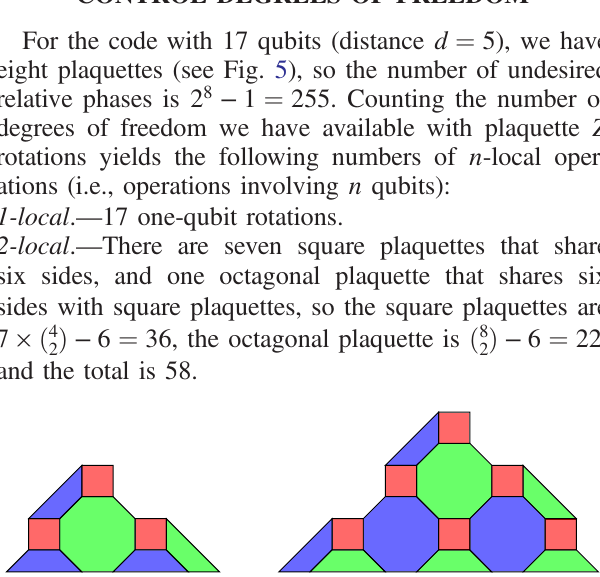
FIG. 5. Larger instances of planar color codes. The 17-qubit code (a) encodes a logical qubit of logical distance d ¼ 5 ; the 31- qubit code (b) has distance d ¼ 7 . Whereas the 17-qubit code would, at least in principle, allow for the correction of the undesired phases with physically quasilocal rotations, acting only on subsets of qubits belonging to the same plaquette, phase compensation for the 31-qubit case (and larger codes) would require nonlocal rotations involving qubits of several plaquettes.